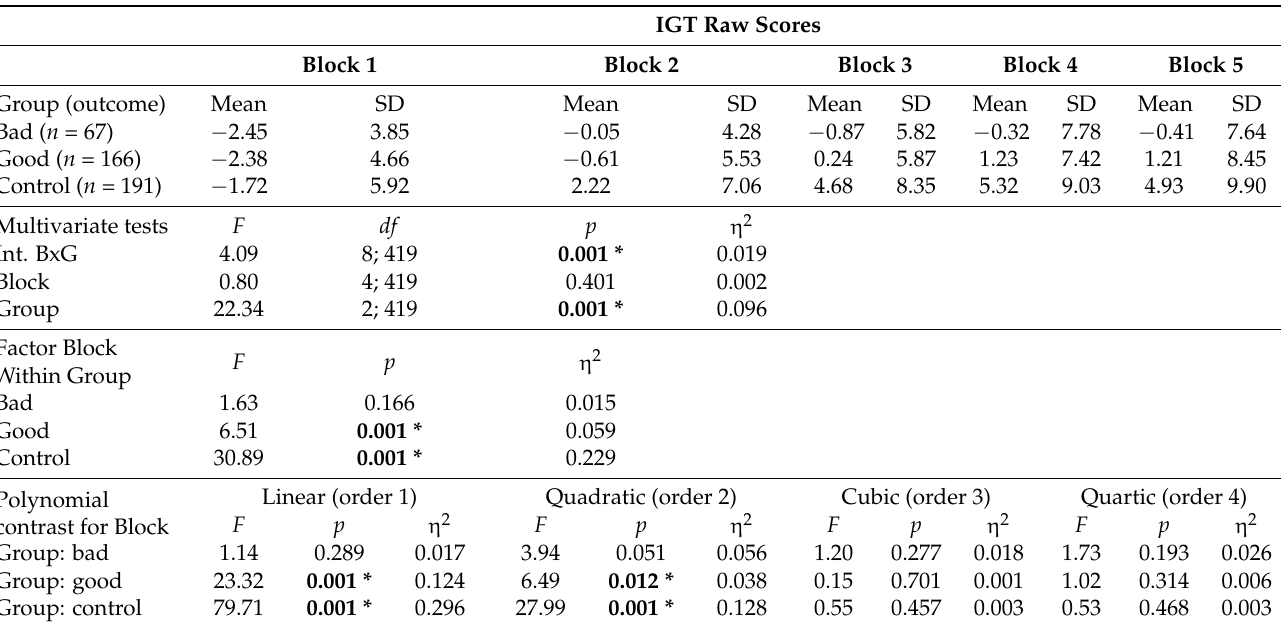
Table 1. Performance learning curves in the Iowa Gambling Task (2 × 5 ANOVA adjusted by age and education). IGT Raw Scores Block 1 Block 2 Block 3 Block